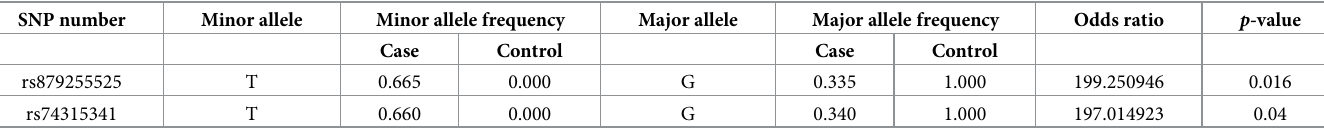
Table 1. Allelic frequency distribution.